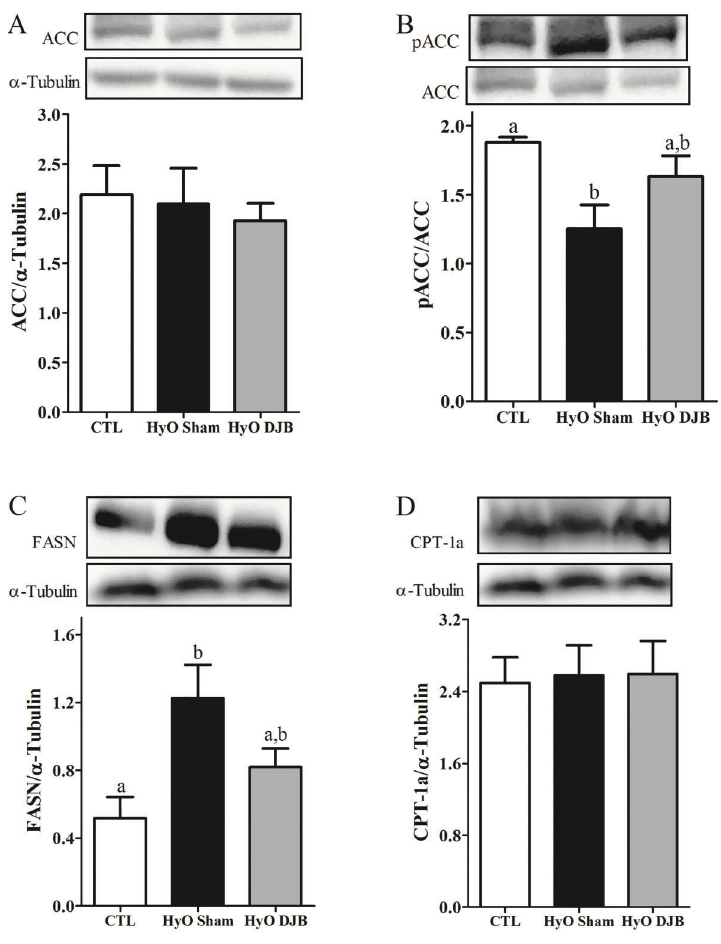
Figure 3. Hepatic protein expressions of ACC ( A ), pACC Ser79 /ACC ( B ), FASN ( C ) and CPT-1a ( D ) in control (CTL), hypothalamic obese (HyO) Sham and HyO with duodenal-jejunal bypass (DJB) rats. Data are reported as means ± SEM (n=5 – 8 rats). P o 0.05, different letters indicate signi fi cant differences (one-way ANOVA followed by the Tukey